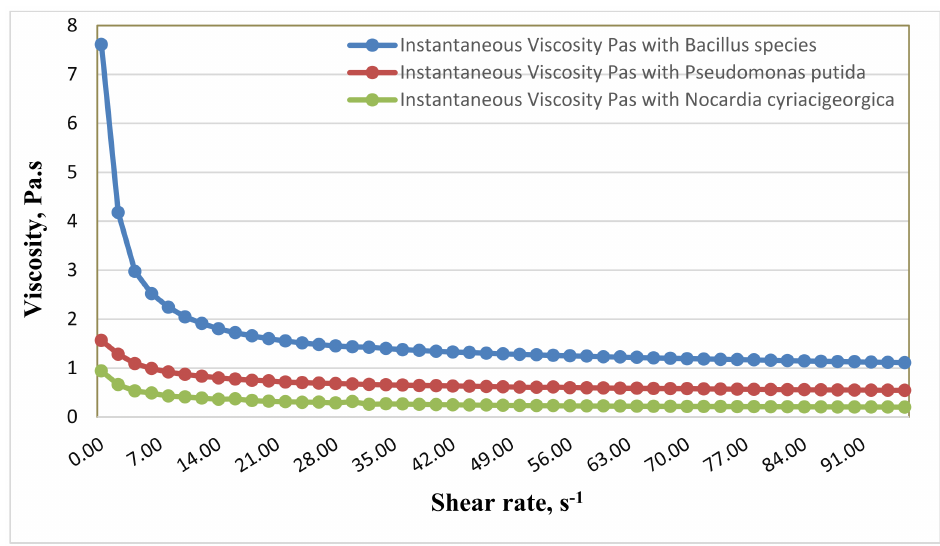
Figure 2. Reduction in viscosity of crude oil treated with Bacillus species, Pseudomonas putida , and Nocardia cyriacigeorgica at 55 ◦